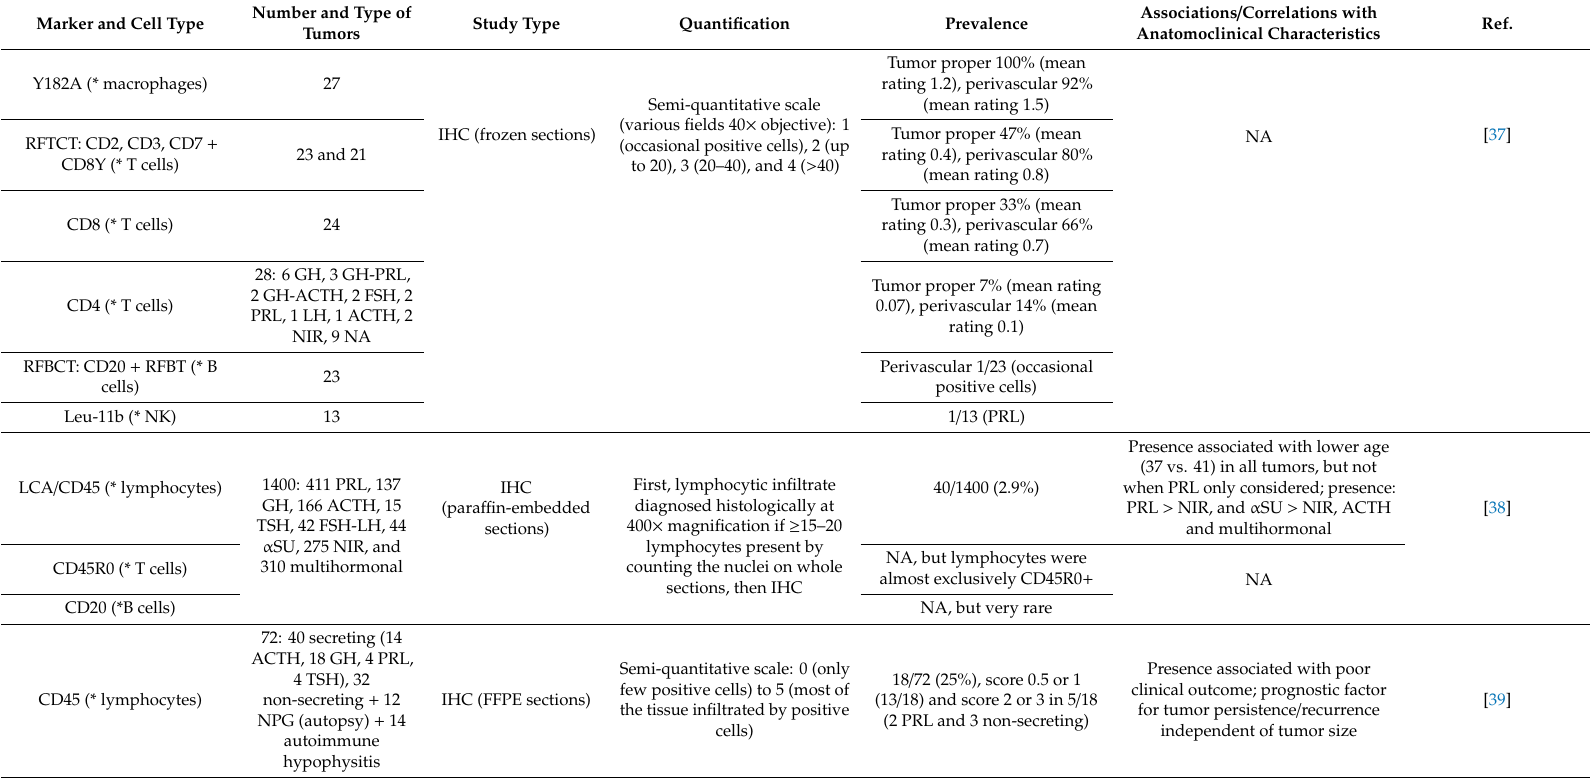
Table 2. Immunohistochemical studies of the immune microenvironment of human pituitary tumors. Marker and Cell